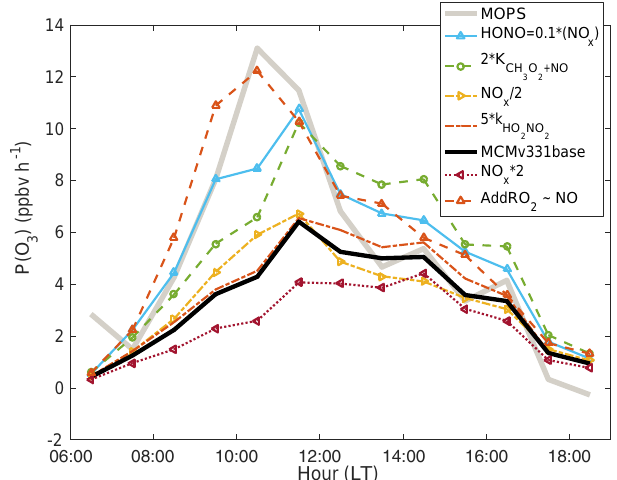
Figure 6. Model P(O 3 ) scenarios using MCMv331 calculated for daytime P(O 3 ) hours between 06:00 and 18:00LT. Median hourly P(O 3 ) is derived from the model case studies described in the main text and compared to the MOPS median diel P(O 3 ) and MCMv331 median diel base